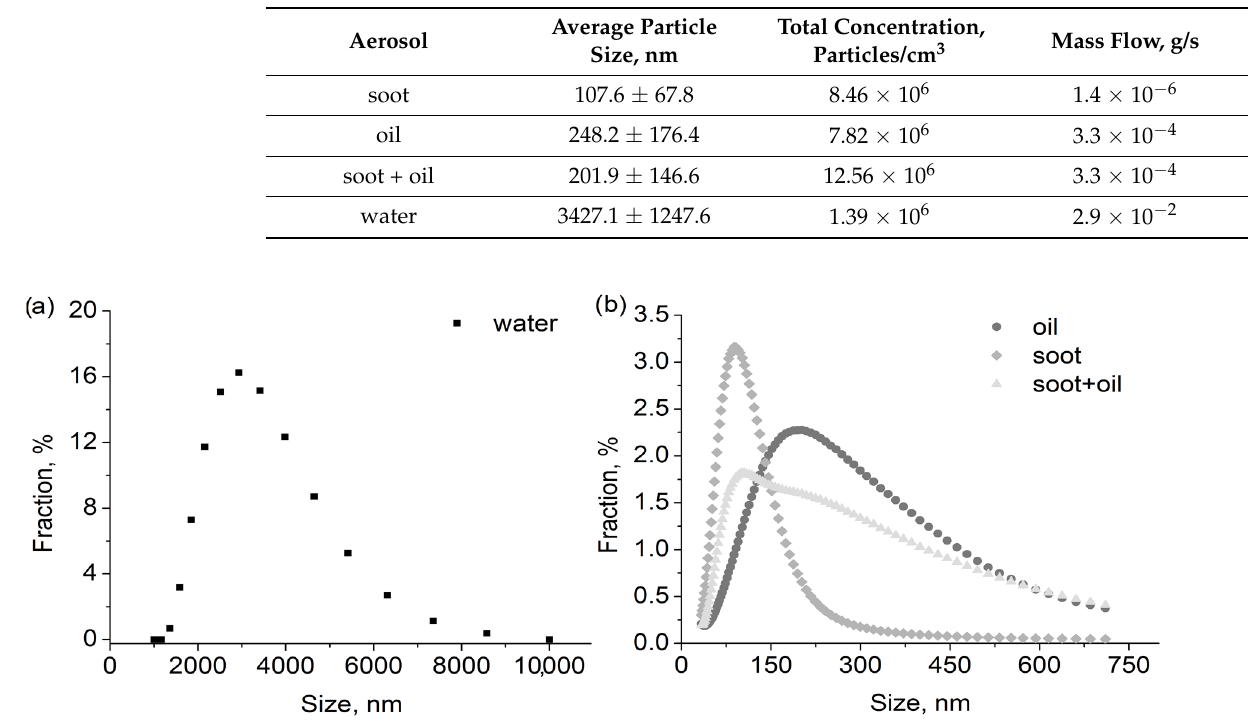
Figure 3. Particle size distribution for ( a ) water and ( b ) oil and soot aerosols.